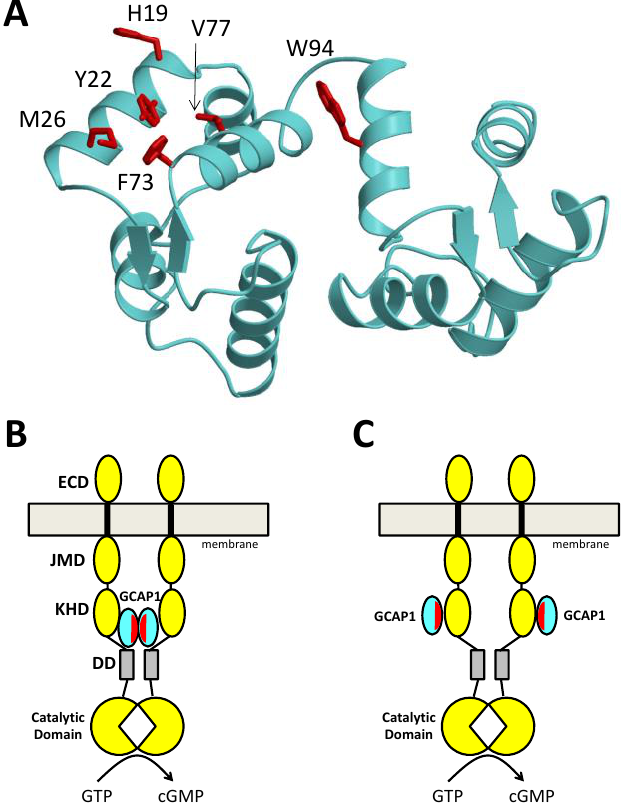
Figure 6. Druggable Hotspot on GCAP1 ( A ) and RetGC activation by dimeric ( B ) or monomeric ( C ) GCAPs. The structure of GCAP1 (cyan) contains exposed hotspot residues (red) that can mediate GCAP dimerization ( B ) or RetGC binding ( C ). RetGC (yellow) is proposed here to be activated by either a preformed GCAP1 dimer ( B ) or by monomeric GCAP1 ( C ). Small molecule drugs or peptides that bind to the hotspot are expected to prevent cyclase activation by constitutively active GCAP1 mutants and therefore may serve as therapeutics for cone-rod dystrophies. Each RetGC dimer subunit (yellow) is composed of an extracellular domain (ECD), transmembrane domain (black), juxtamembrane domain (JMD), kinase homology domain (KHD), dimerization domain (gray), and catalytic cyclase domain.